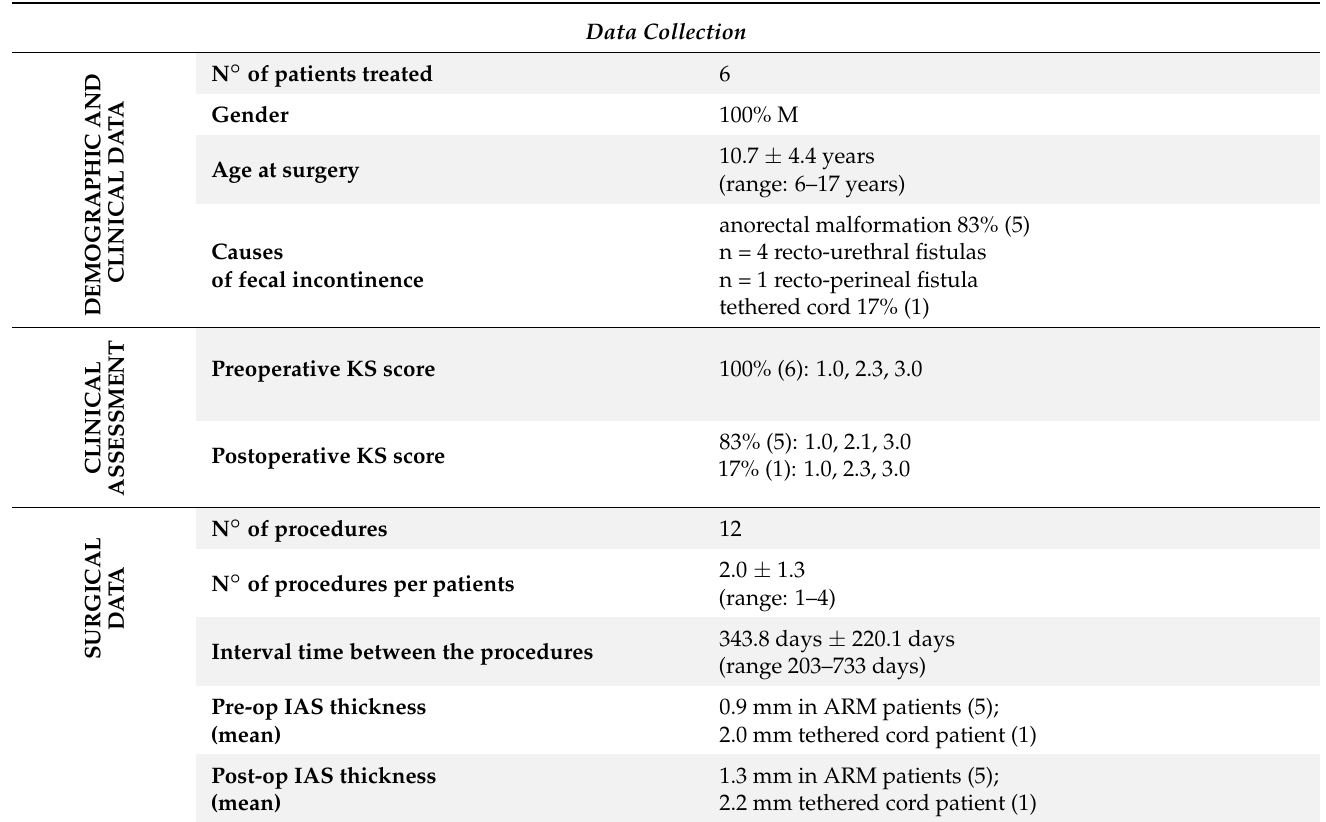
Table 3. Patient and surgery